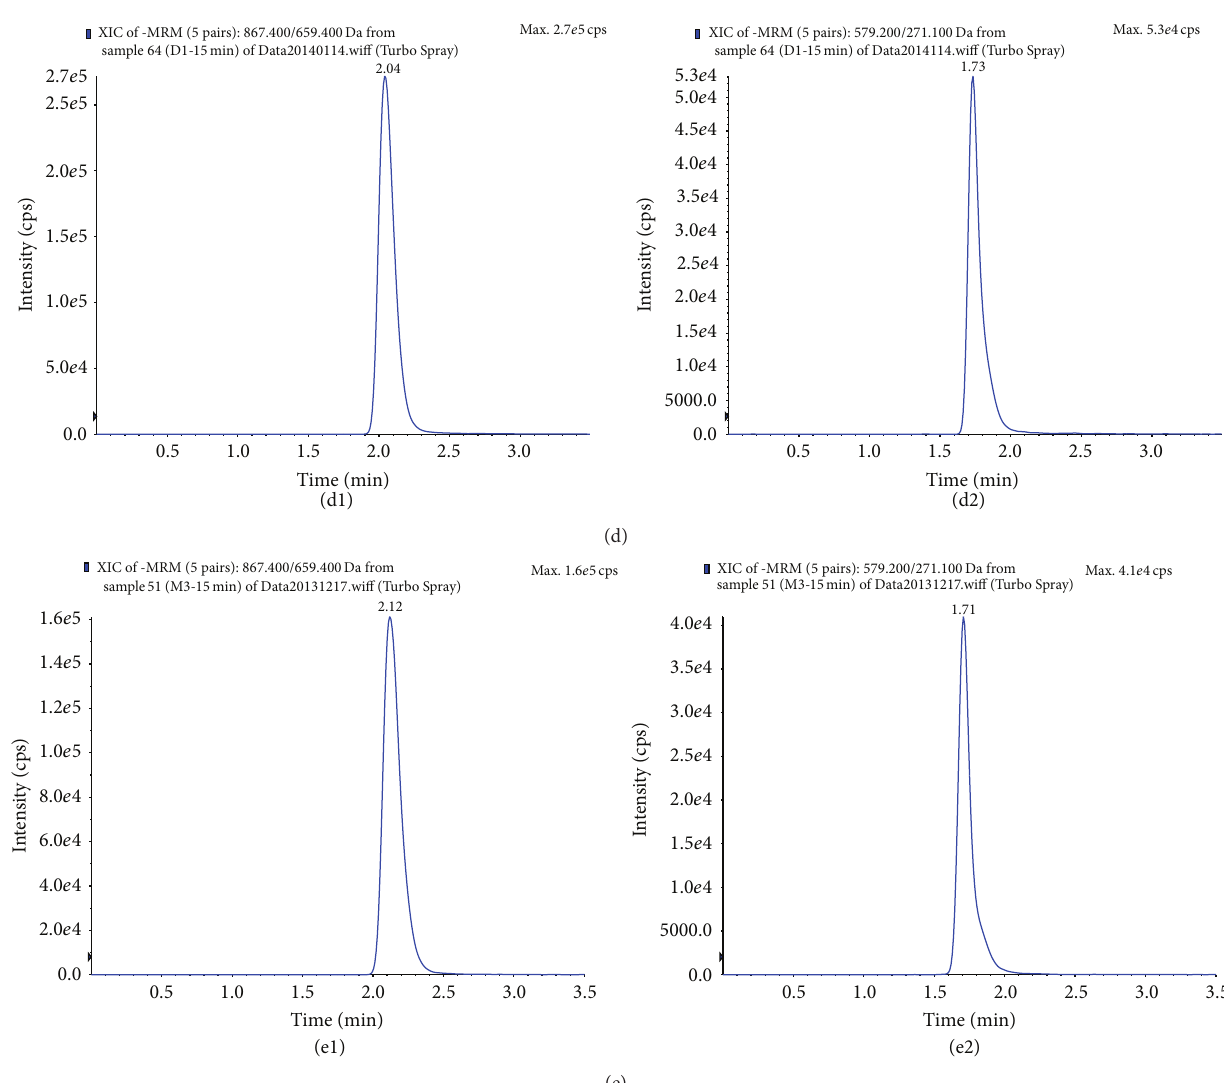
Figure 4: Typical MRM chromatograms of epimedin C (1) and IS (2). (a) Blank rat plasma; (b) blank plasma sample spiked with epimedin C at LLOQ and IS (66.7 ng/mL); (c) rat plasma sample at 15 min after intramuscular injection of epimedin C; (d) rat plasma sample at 15min after intramuscular administration of combination solution of four flavonoid glycosides; (e) rat plasma sample at 15min after intramuscular administration of